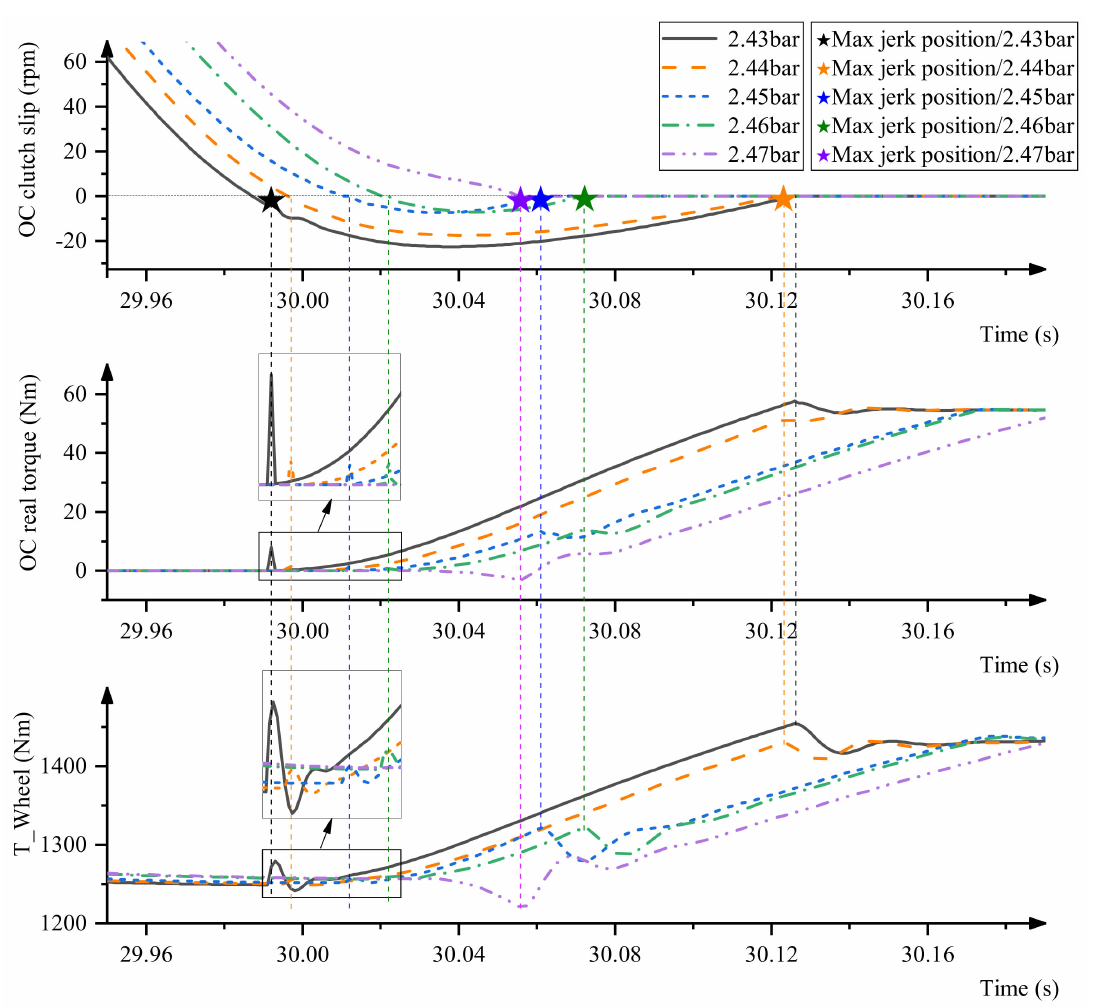
Figure 12. Variation of the OG clutch torque and wheel output torque under different P 2